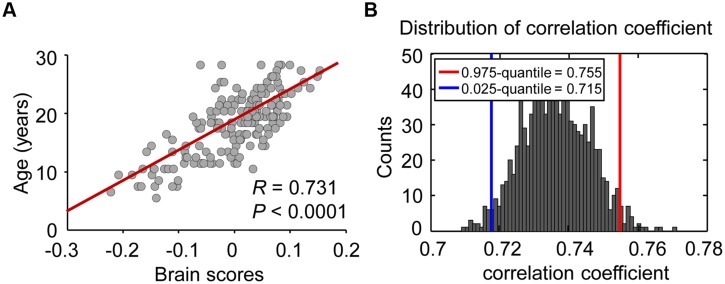
Relationship between brain score and maturation age.(A) Individual brain scores, reflecting the maturity of the brain, were equal to the dot products of connectivity salience and ALFF-FC coefficient vectors. Scatter plots of the age and brain score were constructed to view the correlation between these two parameters, and age was treated as a continuous variable. (B) In the reliability test, 1000 bootstrap resamples were performed to estimate the distribution and 95% confidence intervals of correlation coefficients between brain score and age.